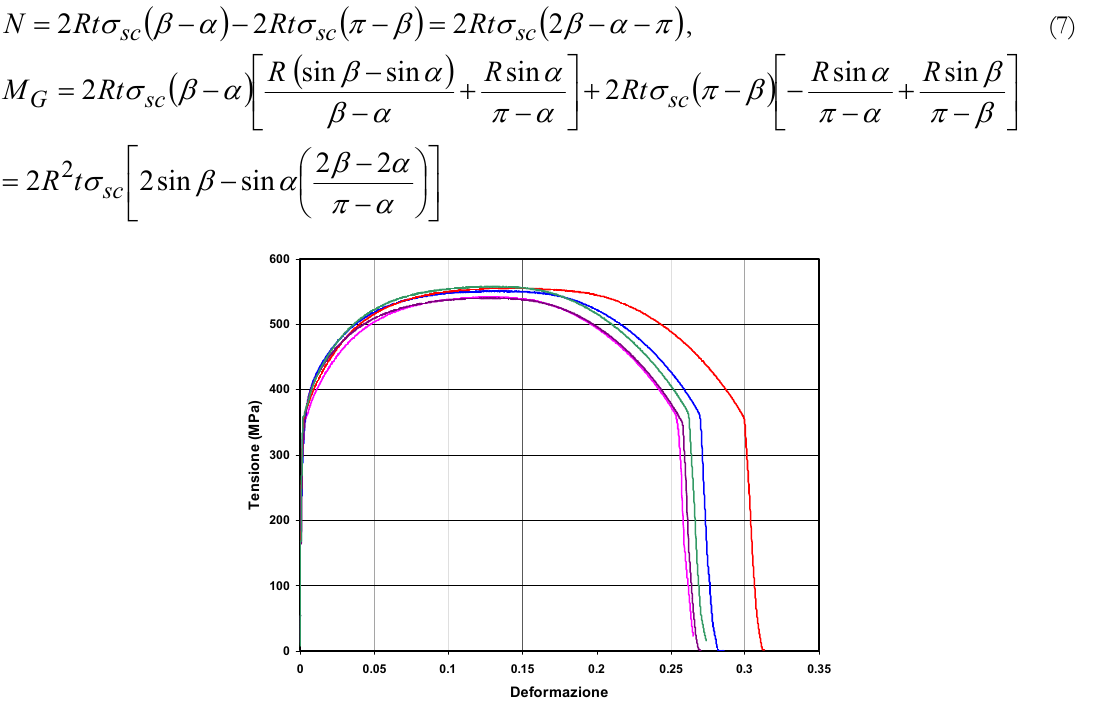
Figura 12: Curve  ottenute dalla caratterizzazione sperimentale del materiale effettuata mediante